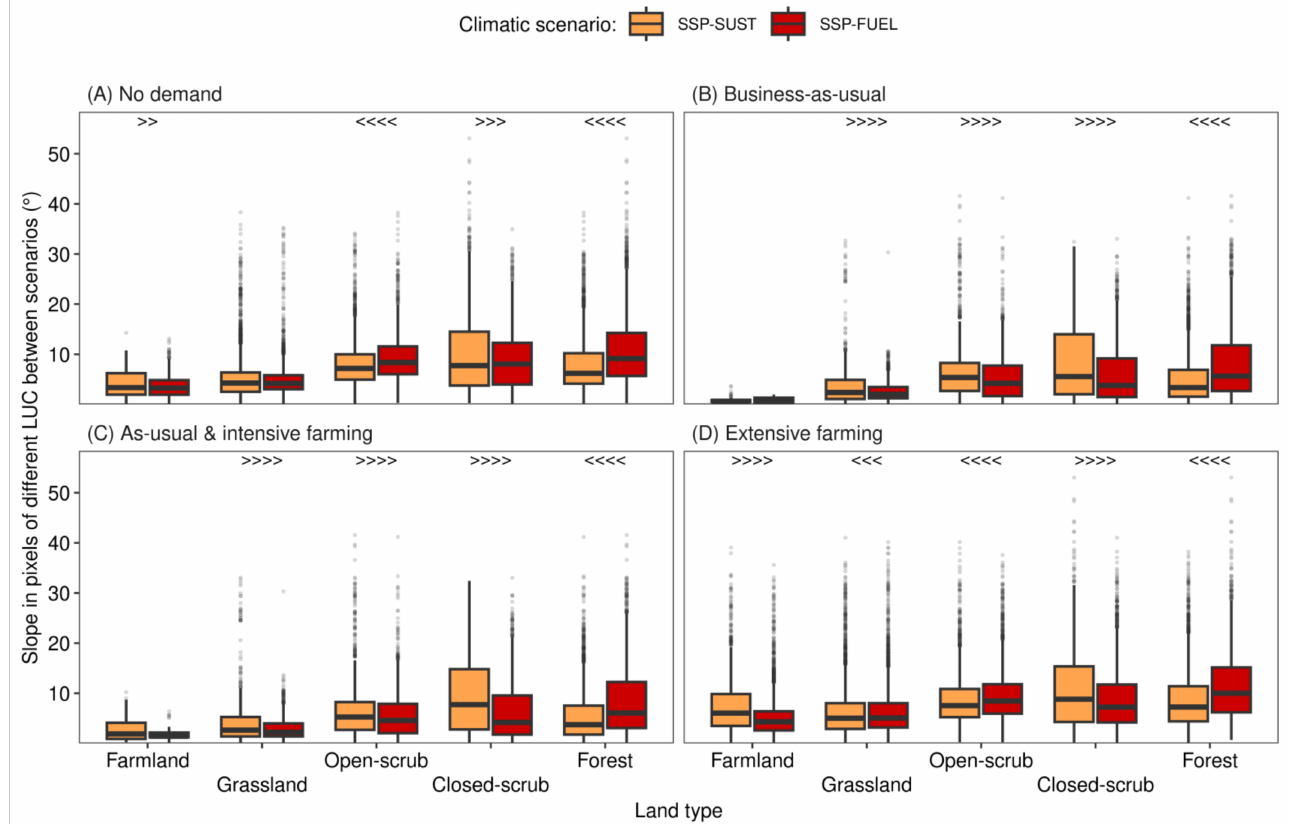
Figure 7. Slope of LUC type at the map cells which differed in the prediction of LUC between the most optimistic (SSP-SUST) and most pessimistic (SSP-FUEL) climatic scenario, under each of the following four scenarios of demand in 2015–2055 LUC transitions: ( A ) no pre-specified demand; ( B ) as-usual from 1996–2015 to 2015–2055; ( C ) as-usual, but with the 2015 intensive farming preserved; and ( D ) inverse transitioning to 1970 which had characteristics of extensive farming. Inequality symbols above the boxplots indicate statistically significant difference in the median slope by Wilcoxon test between scenarios. In specific, four inequality symbols were used for p -value ≤ 10 − 4 , three symbols for p ≤ 10 − 3 , two for p ≤ 0.01, one for p ≤ 0.05, and no symbol for p > 0.05 level of statistical